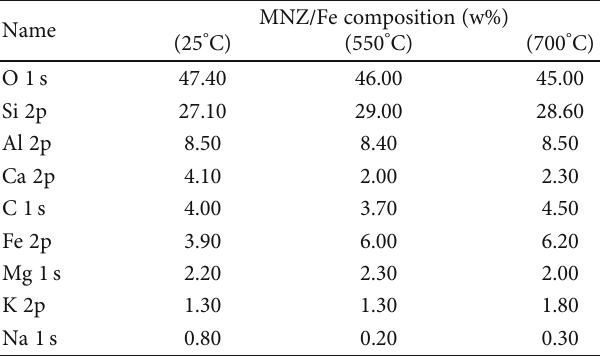
Figure 2: XPS spectra of MNZ/Fe: uncalcined at 25 ° C and calcined at 550 and 700 ° C. Table 1: MNZ composition impregnated with 10mg FeCl for calcined and uncalcined samples.